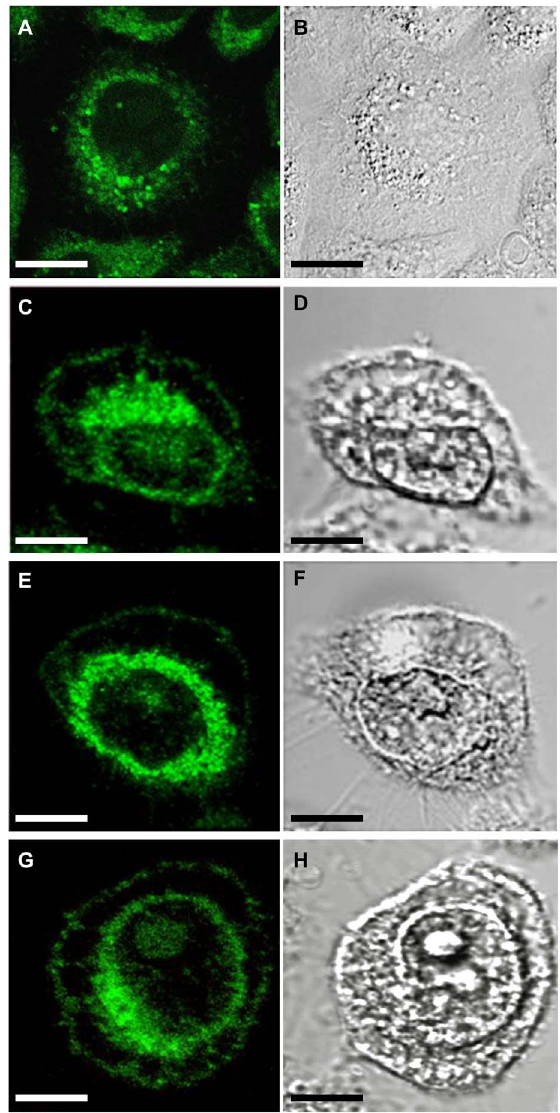
Figure 5. Confocal microscopy of ARP2 fusion protein ex- pressed in CHO cells. CHO cells transfected with arp2-egfp cDNA examined at 16, 24, 48 and 72 h post-transfection ( A , C , E and G respectively). Same using DIC microscopy ( B , D , F and H respectively). Scale bar 10 m m.